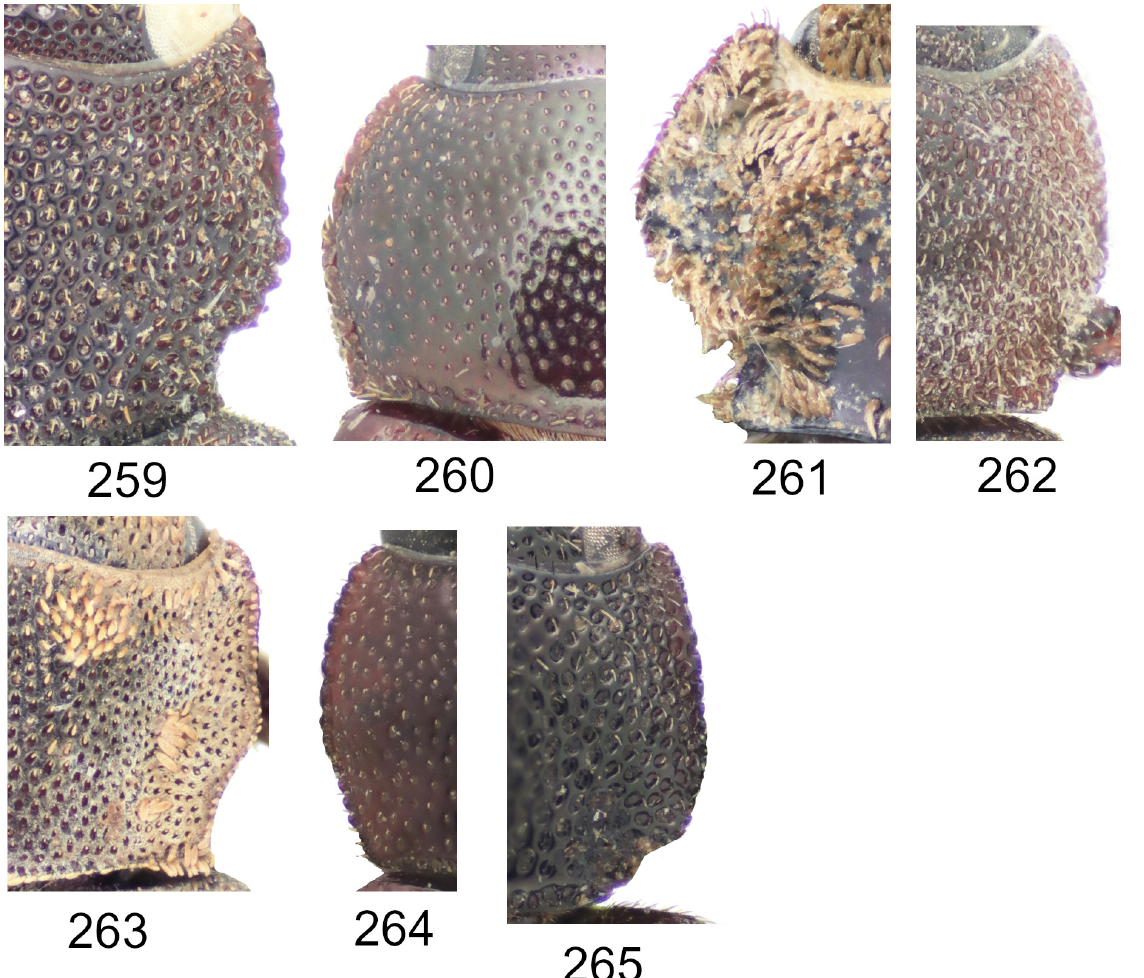
Figs 259–265. Papuan and Wallacean Maechidius Macleay, 1819, pronotum, dorsal view. 259 . M. tarsalis Arrow, 1941, lectotype, ♂ (BMNH). 260 . M. trivialis sp. nov., holotype, ♂ (BMNH). 261 . M.